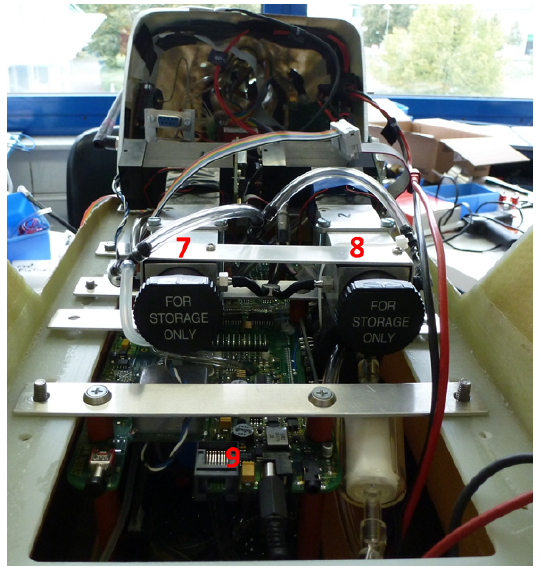
of the air plane and consists of two condensation particle counters (7 and 8) and one optical particle counter (9) that is mounted under- neath (view from the rear). The first CPC1 (7) detects particle num- ber concentrations in a particle diameter range of 11nm to 2µm. The second CPC2 (8) measures the particle number concentrations between 18nm and 2µm.